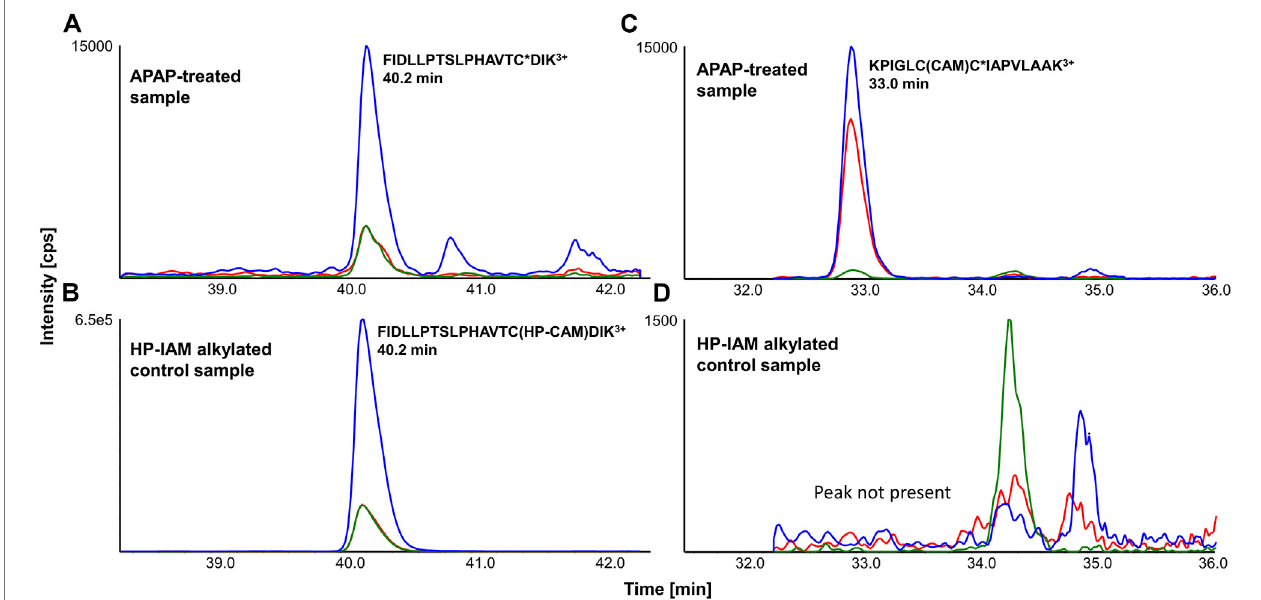
FIGURE 2 | Representative LC-MRM chromatograms of (A) FIDLLPTSLPHAVTC*DIK 3+ (from cytochrome P450 2C29) from an APAP-treated liver digest and (B) its reference in HP-CAM control sample in mouse (from SPE fraction 3), as well as (C) KPIGLCC*IAPVLAAK 3+ (from mitochondrial ES1 protein homolog) from an APAP- treatedliverdigestand (D) itscorrespondingly absentsignalintheHP-CAMcontrolsampleinratduetothepresenceoftwocysteinesinitssequence(fromSPEfraction 8). The star (*) in the peptide sequence indicates the con fi rmed site of APAP modi fi cation.